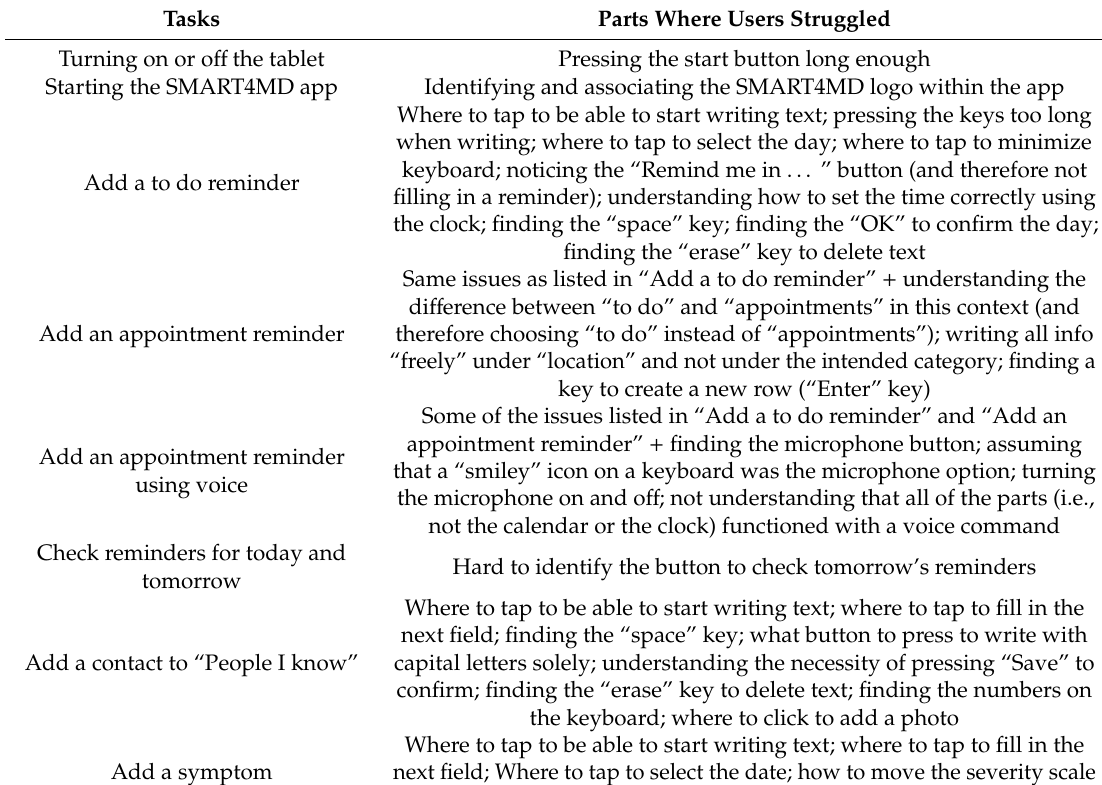
Table 3. Parts where users struggled when solving tasks in the usability